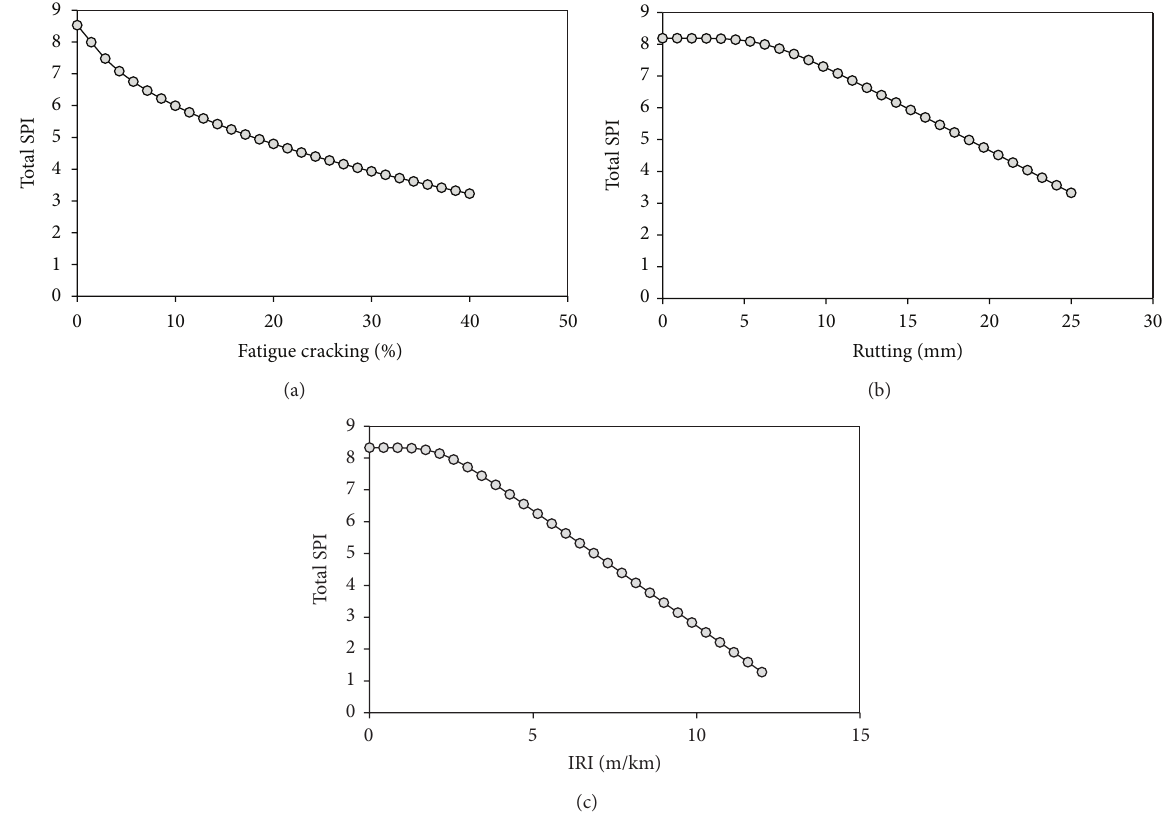
Figure 3: Distress models: (a) fatigue cracking, (b) rutting, and (c) IRI. Table 1: Costs of the rehabilitation